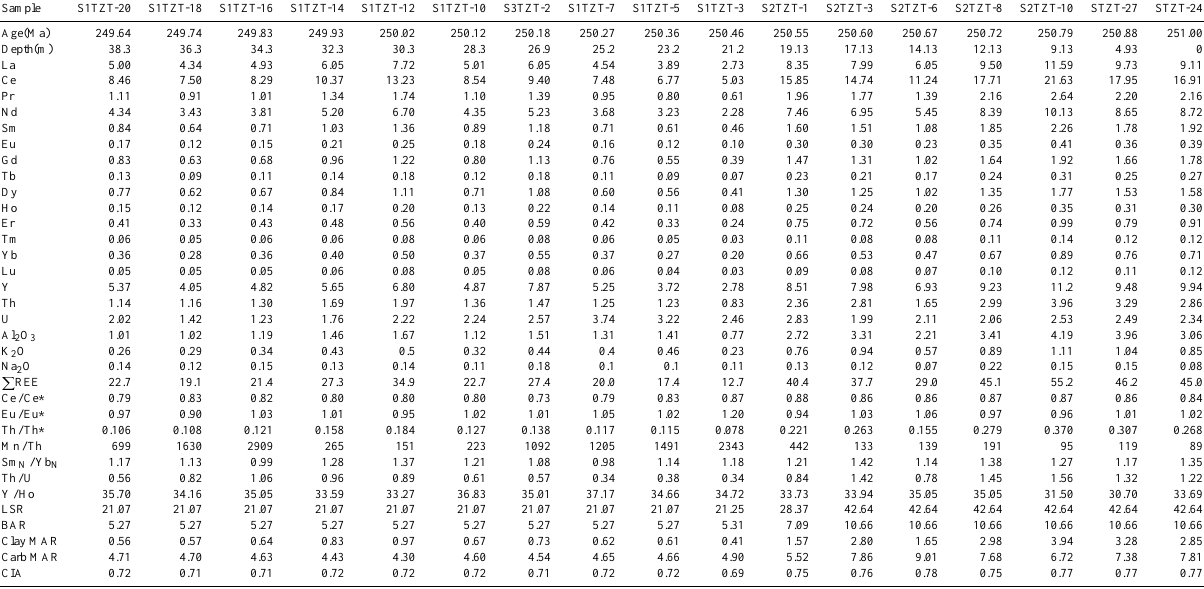
Table C2. Major and trace element concentrations and ratios for the Shitouzhai section.